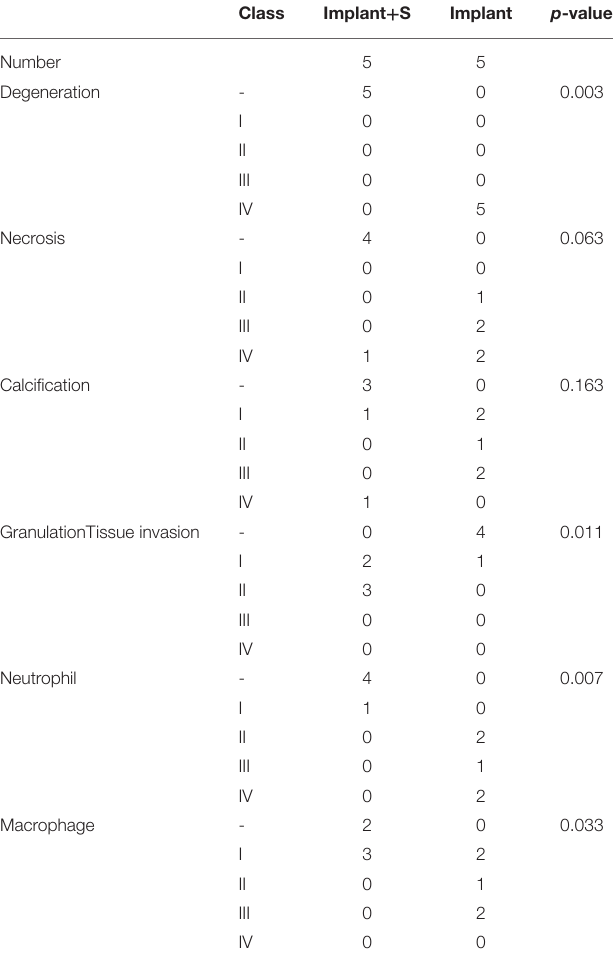
fibrous. The active mechanism means valvular infiltration of TABLE 2 | Histopathologic analysis of non-GLUT BHVs in implant and implant + S groups after 56 days of implantation. cell or cell elements (calcium-binding proteins, macrophage, T lymphocyte, and matrix metalloproteinase). Several studies Class Implant + S Implant p -value have suggested an association between inflammation, reactive oxygen species, thrombogenicity, coagulation, and calcification. Mechanical stress and cyclic loading are more likely to